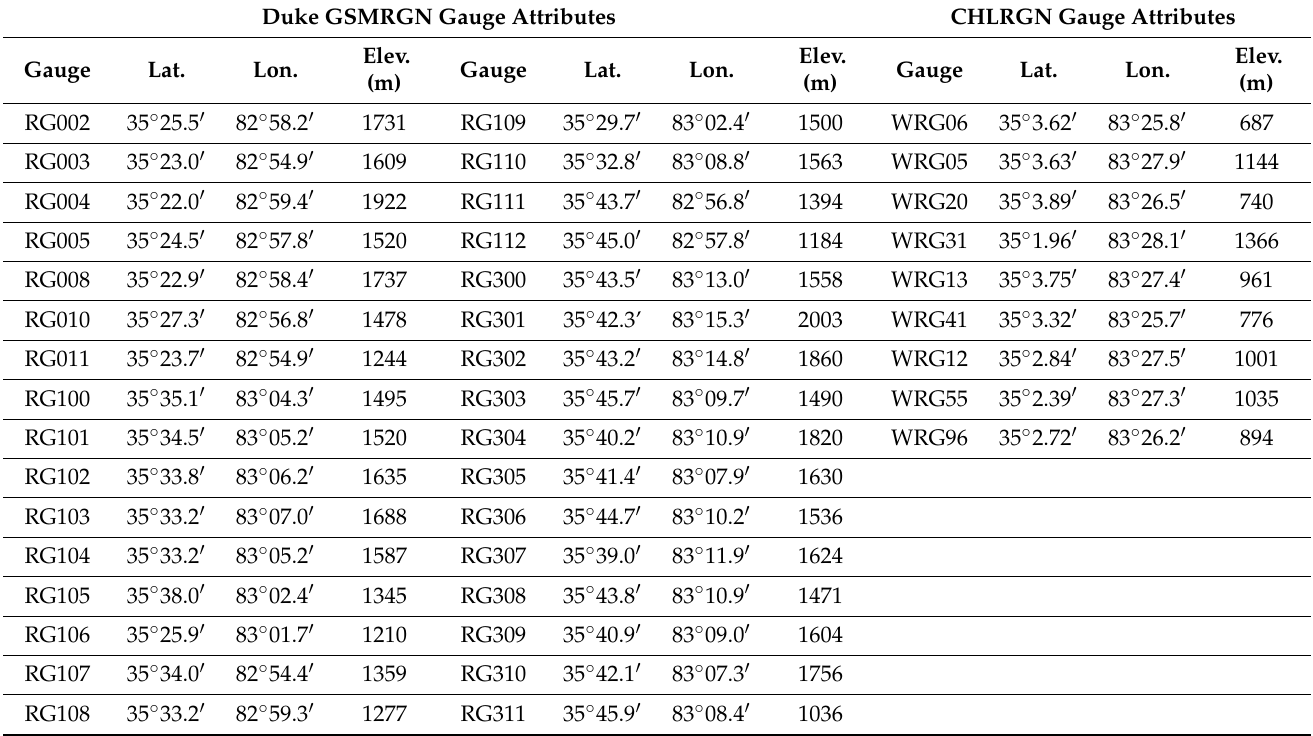
Table A1. Location and elevation of the 32 tipping bucket rain gauges comprising the Duke GSMRGN and of the nine NOAH IV weighing rain gauges (WRGs) comprising the CHLRGN.